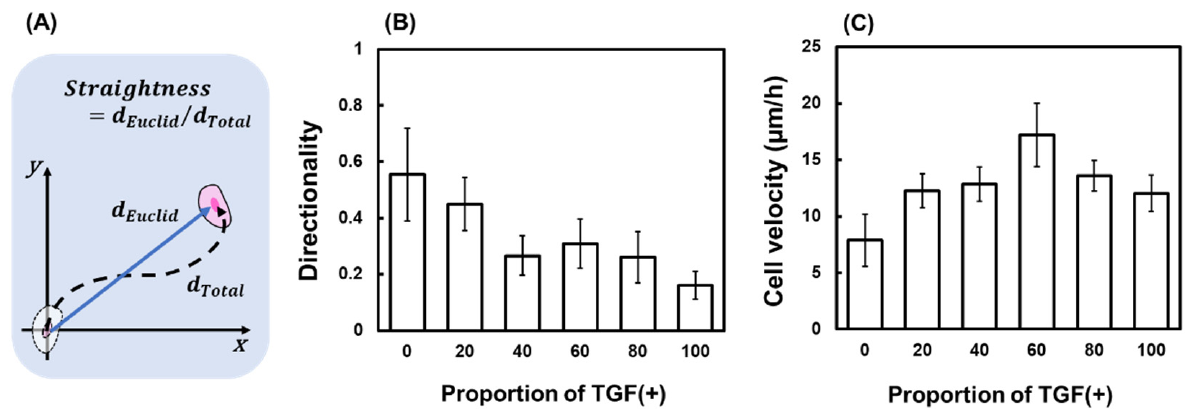
Figure 5. Changes in migration direction and velocity. ( A ) Definition of straightness. ( B ) Mean straightness of all cells with different TGF (N). ( C ) Mean velocity of all cells with different TGF (N).